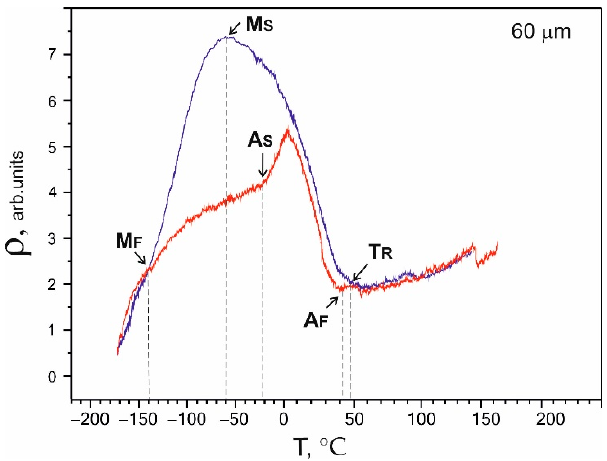
Figure 7. Temperature dependence of electrical resistivity ρ (T) for a 60 µm thick sample.